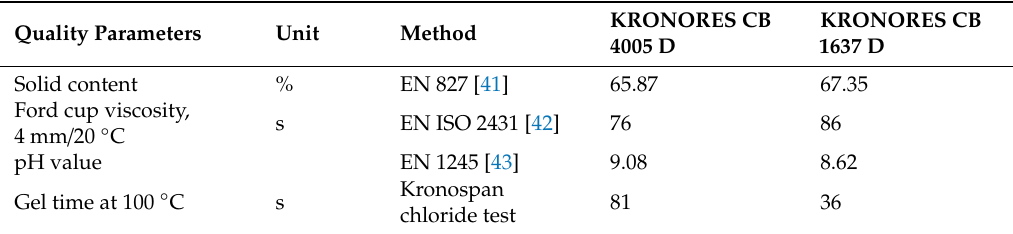
Table 1. Properties of urea–formaldehyde (UF)